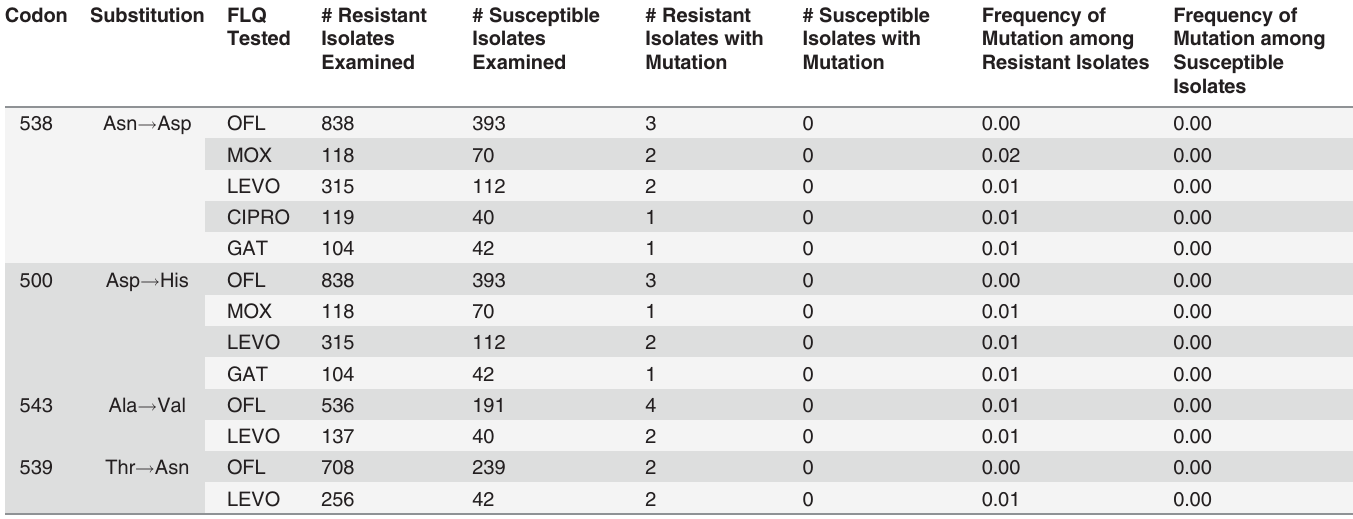
Table 4. Cumulative Frequencies of the Most Frequently Occurring Mutations within gyrB Gene among Mycobacterium tuberculosis Isolates Resistant to Fluoroquinolones. Mutations are listed in order of descending frequency. Codon Substitution FLQ